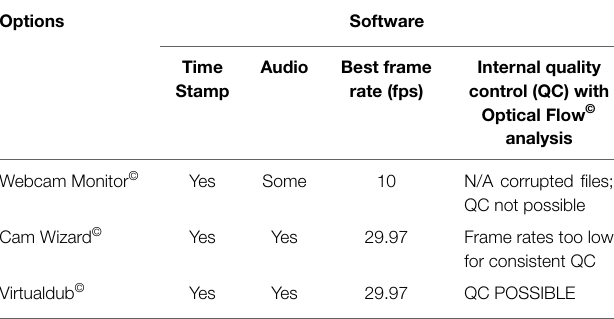
TABLE 2 | Software option test process